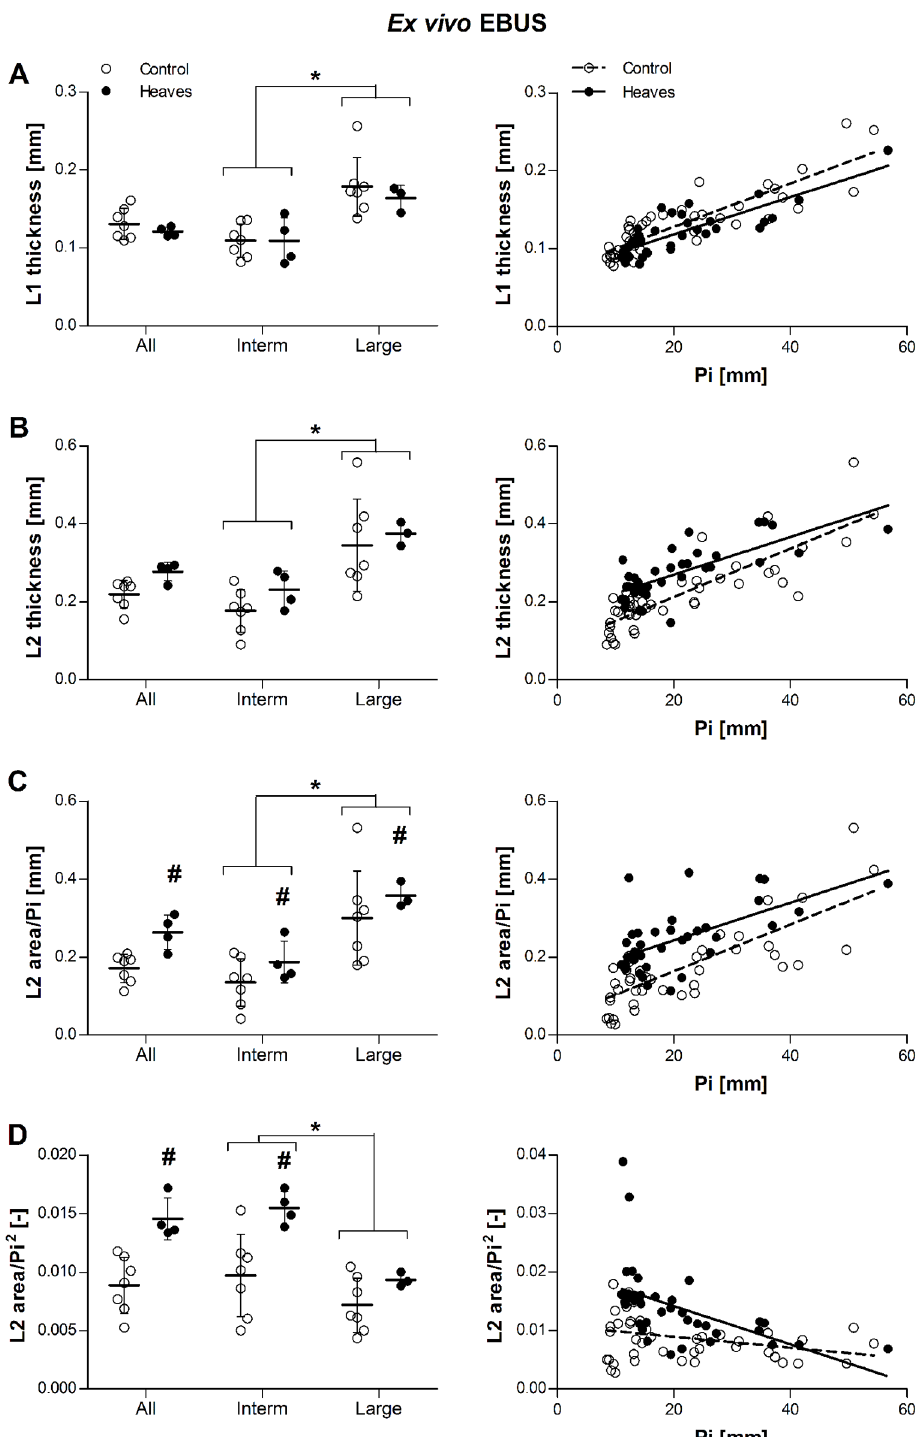
Fig 5. Effect of group and airway size on L1 thickness (A), L2 thickness (B), ratio L2 area/Pi (C), and ratio L2 area/Pi 2 (D) in ex vivo EBUS. Raw data (before statistical corrections) are presented as mean per animal in the graphs on the left, and as mean per airway the graphs on the right. L1 and L2 thickness was similar in horses with heaves and controls across all bronchi (p = 0.4 and p = 0.1, respectively). Contrarily, L2 area/Pi and L2 area/Pi 2 ratios were greater in horses with heaves than controls across all bronchi (p =